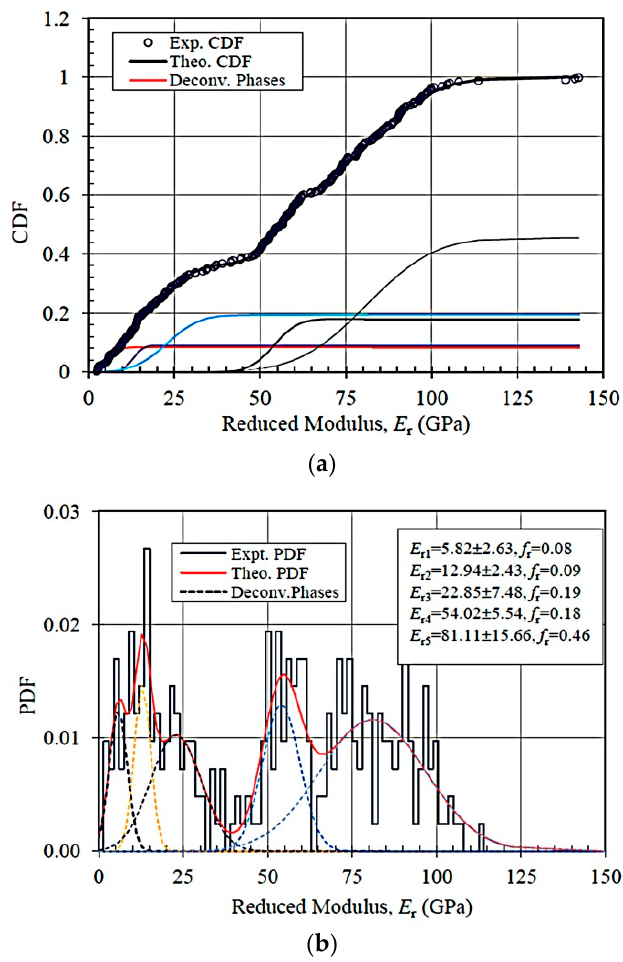
Figure 5. Reduced modulus deconvolution of ANC-1 data ( a ) CDF ( b ) PDF; E ri : reduced modulus of phase i ( i = 1: microporosity; i = 2: mixed geopolymer-clay matrix; i = 3: C-S-H; i = 4: nano-crystallites; i = 5: inclusions); f r : volume fraction. Table 2. Reduced modulus of constituent phases obtained from statistical analysis of grid indentation results for three different trials.